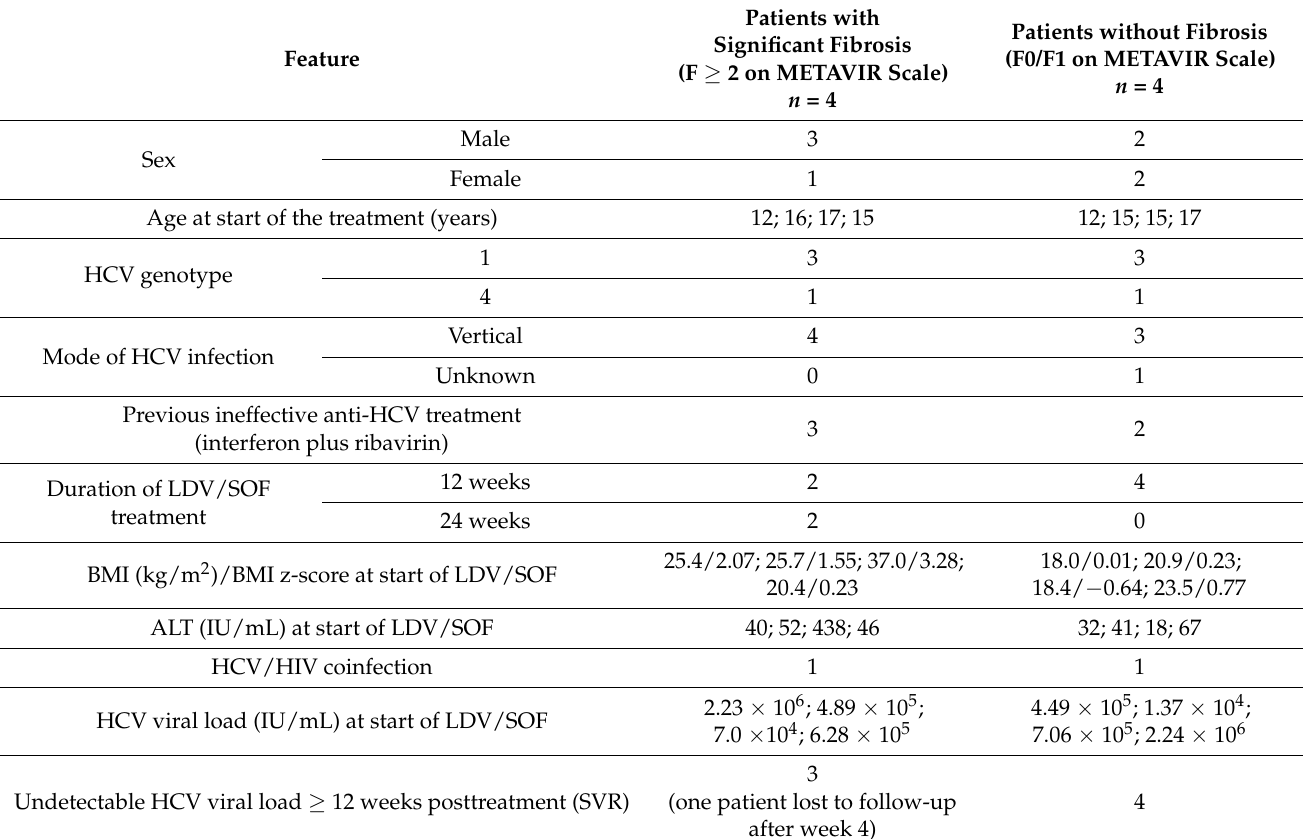
Table 1. Clinical and laboratory characteristics of patients with chronic hepatitis C treated with ledipasvir/sofosbuvir according to their baseline stage of